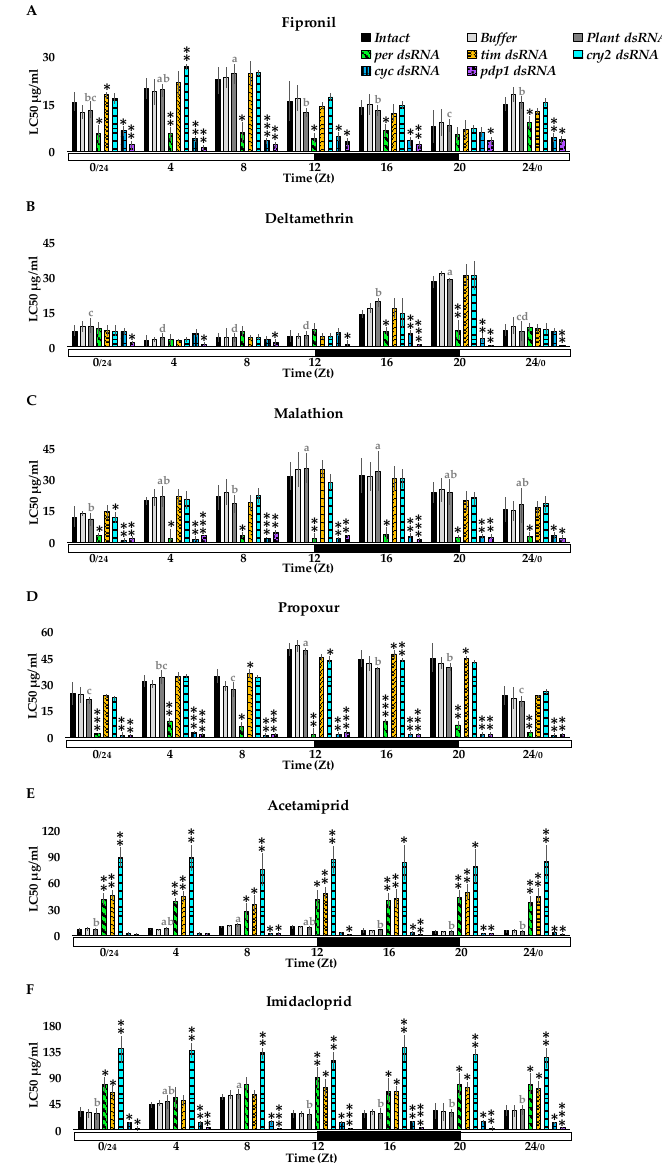
Figure 5. RNAi-mediated disruption of clock genes expression affects daily susceptibility patterns and results in increased larvae sensitivity to insecticides (the flowchart of the experiment is shown in Scheme 1B). The 2-day-old larvae of the 6th instar were exposed to fipronil ( A ), deltamethrin ( B ), malathion ( C ), propoxur ( D ), acetamiprid ( E ), and imidacloprid ( F ) at various concentrations for one hour at given time points. Data are shown as the average LC50 (±SEM) at 24 h after exposure to insecticides for larvae injected with clock genes dsRNAs (green bars with diagonal lines for per , orange bars with wavy lines for tim , turquoise bars with horizontal lines for cry2 , light blue bars with square grid for cyc , and purple bars with dots for pdp1 ) and in larvae which serve as controls: untreated (Intact — black bars), injected with buffer used for in vitro transcription (Buffer — light gray bars), or SSU dsRNA of N. tabacum (Plant dsRNA — dark gray bars). Values with different letters for the data of the Intact group differ significantly ( p < 0.05), as calculated by an ANOVA and Bonferroni post-test. Significant differences between mean values for larvae treated with clock gene dsRNA and from control groups in the given time points were calculated by an ANOVA and unpaired t -test; comparisons between the groups treated with the dsRNA of the clock genes and the Plant dsRNA, with * p < 0.05, ** p < 0.01, and *** p < 0.001 (labeled above the bars that indicate data for clock gene dsRNA-treated insects) are